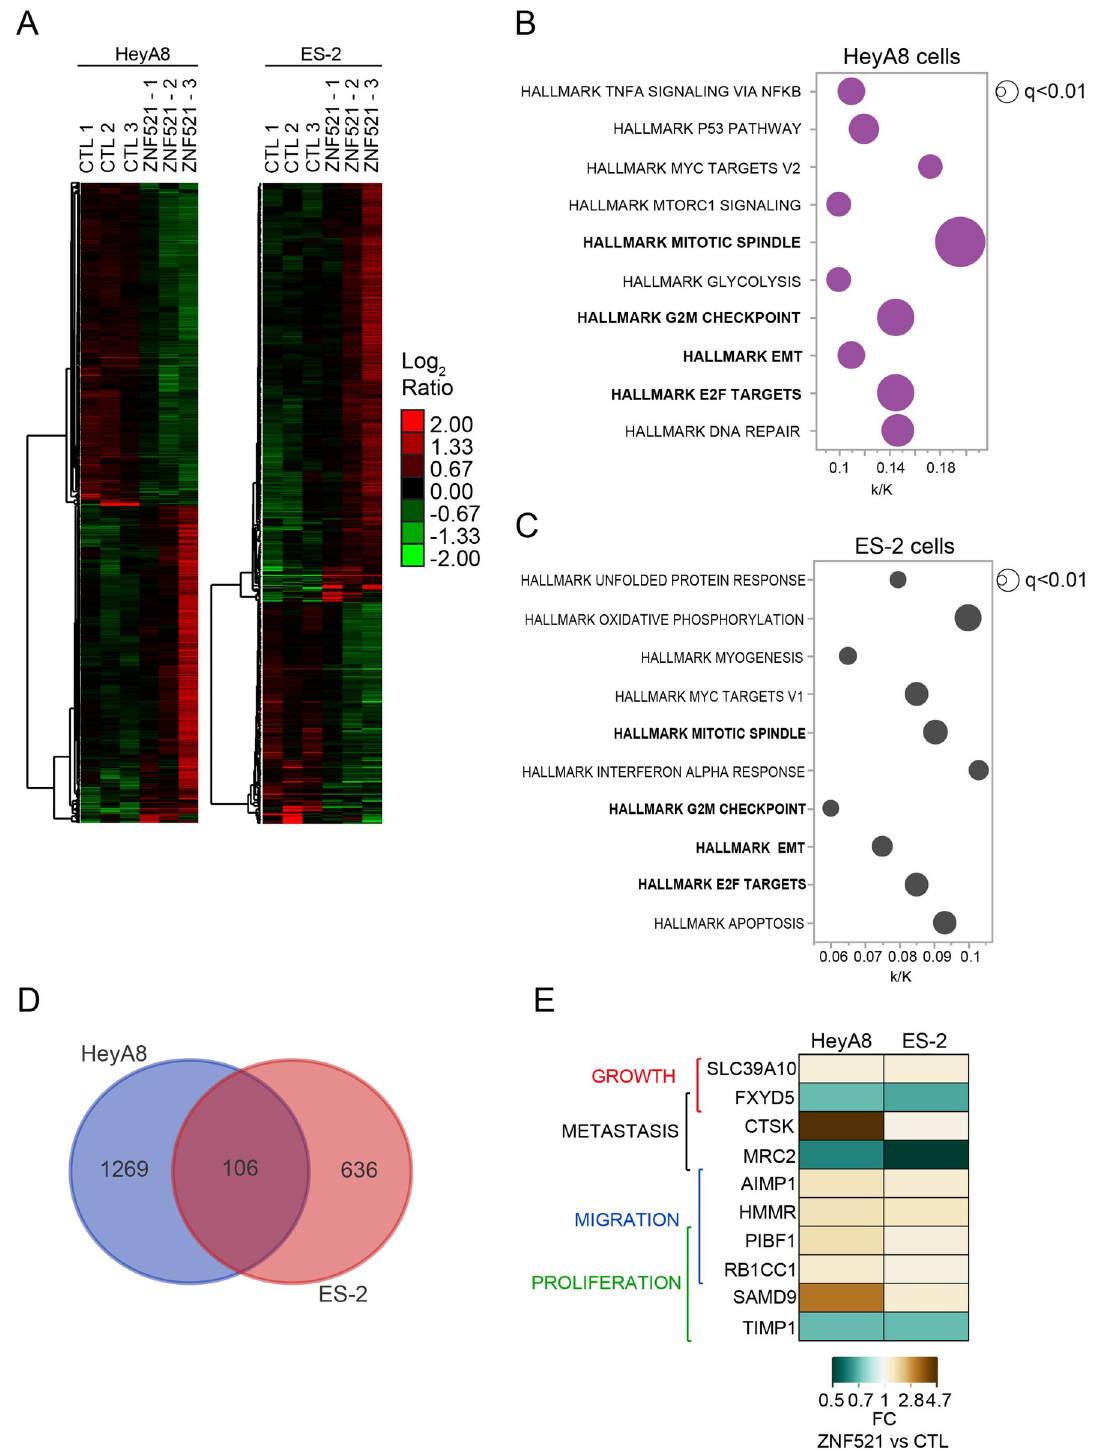
Fig 5. Differentially expressed genes (DEGs) by ZNF521 in hOC cell lines. (A) Hierarchical clustering of the 1375 and 742 differentially expressed genes (p < 0.05) in HeyA8 and ES-2 cells, respectively. Molecular Signatures Database (MSigDB) analysis of HeyA8 (B) and ES-2 (C). (D) Size of dots represents the inverse logarithm (base 10) of statistical significance (FDR q-value) as per the legend. X-axes, fraction (k/K) of overlapping genes (k) in each Gene Set with the total number of genes represented in the specific hallmark (K). In bold, commonly enriched hallmark gene sets. Venn diagram analysis of the 1375 genes differentially expressed in